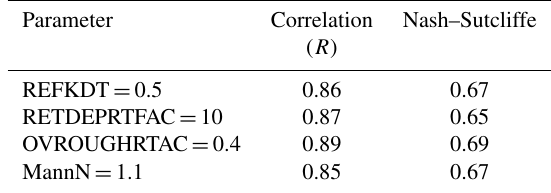
Table 4. The correlation coefficient and the Nash–Sutcliffe test be- tween the observed hydrograph and the simulations for the optimum values of each parameter for Sarantapotamos basin, after the 5h dis- placement of the temporal evolution of the simulated